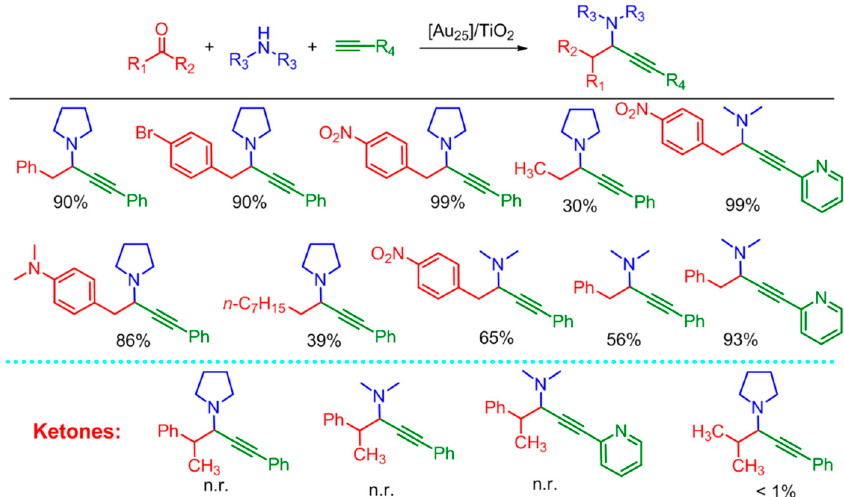
Figure 8. Catalytic results over the Au 25 (PPh 3 ) 10 (PA) 5 X 2 ([Au 25 ] / TiO 2 ) catalysts in the A 3 -coupling reaction. Reaction conditions: 100 mg catalyst (1 wt.% cluster loading), 1.0 mmol benzaldehyde, 1.2 mmol piperidine, 1.3 mmol phenylacetylene, 5 mL water, 100 °C, 18 h, under a N 2 atmosphere.